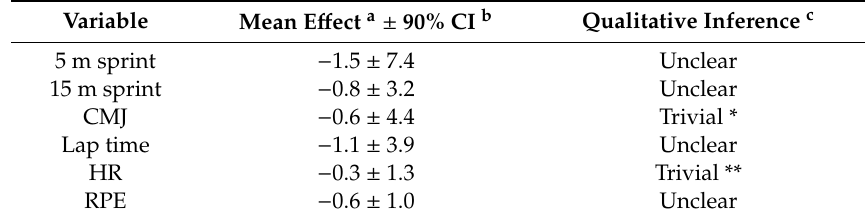
Table 2. E ff ect of MILK vs. CHO on simulated team-sport game variables, 5 m sprint, 15 m sprint, lap time, jump height, heart rate (HR) and rating of perceived exertion